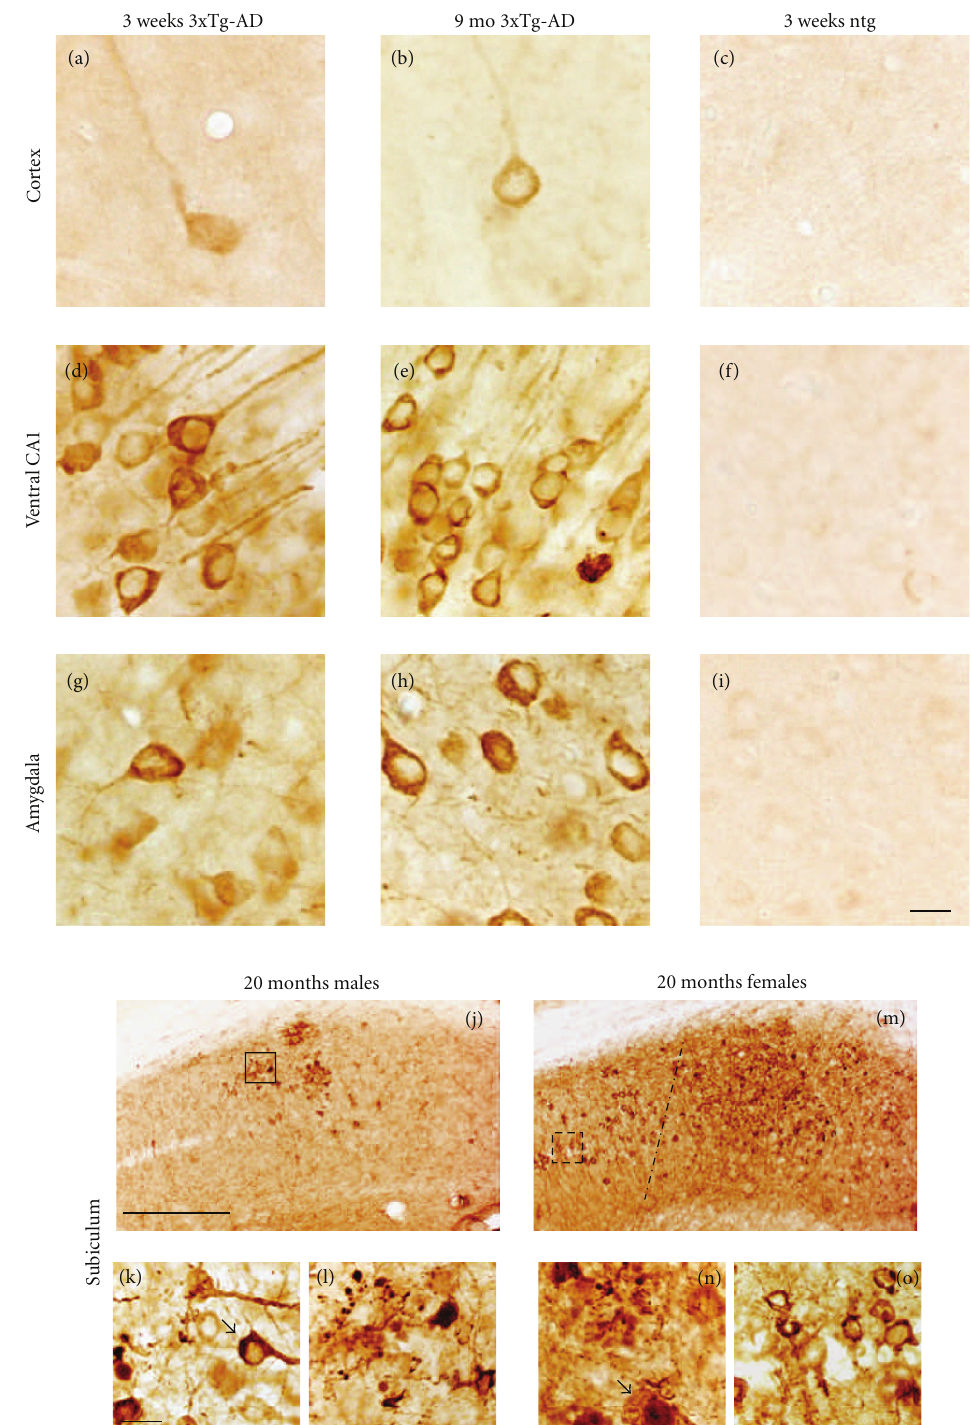
Figure 8: Photomicrographs showing AT8 immunoreactivity in the cortex ((a)–(c)), ventral CA1, ((d)–(f)), BLA ((g)–(i)), and subiculum ((j)–(o)) in 3-week, 9-, and 18–20-month-old 3xTg-AD mice. Transcardially fixed tissue revealed more AT8-ir neurons in the ventral hippocampus than either the neocortex or BLA in 3-week-old 3xTg-AD mice ((a), (d), (g)). Note that AT8-ir neurons within the hippocampus appeared shrunken with blunted dendrites at 9 months of age (e) when compared to younger (d) mutant mice. AT8 immunoreactive dystrophic neurons and plaques were observed in the subiculum of both male and female 20-month-old 3xTg-AD mice ((j)–(o)). Note the dystrophic neuronal morphology in male (k, arrow) and female (n, arrow) mice as well as the extent of tau pathology ((j), (m)). Dash line in m demarcates the boundary between the CA1 field and the subiculum. (l) and (o) represent higher magnification of boxed areas (j) and (m) respectively. Ntg 3-week-old mice displayed virtually no AT8 immunoreactivity ((c), (f), (i)). Scale bars: ((a)–(i)); ((k), (l), (n), (o)) = 20 μ m and (j), (m) = 100 μ